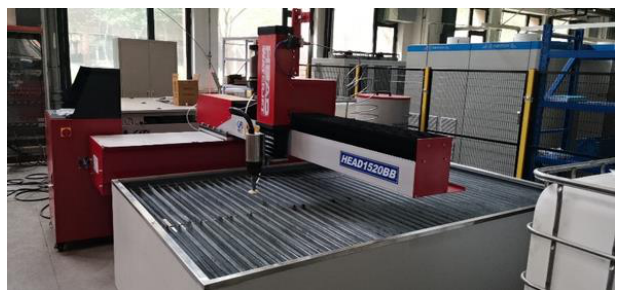
Figure 3. Equipment for sample cutting.